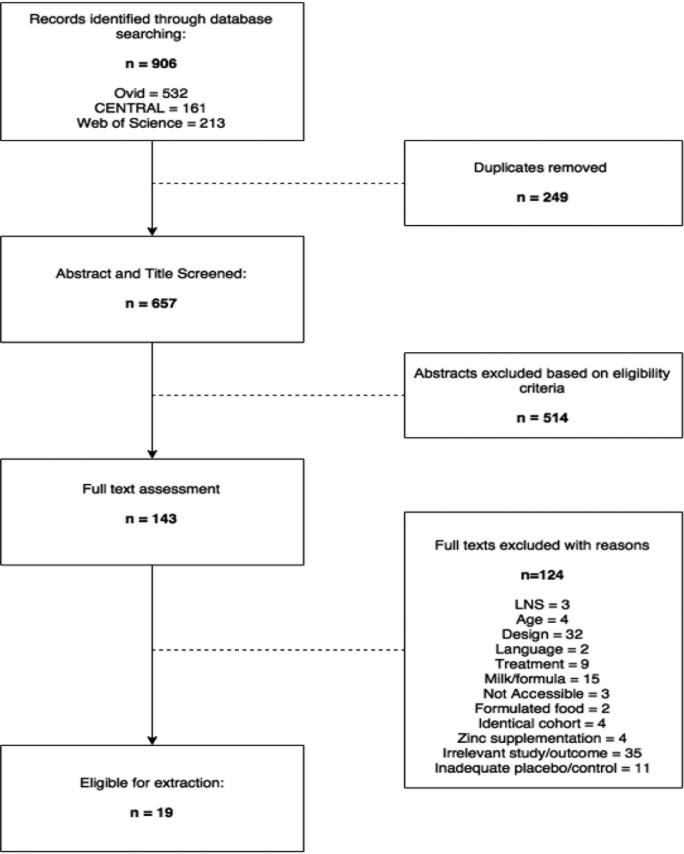
Study selection flow diagram. LNS, lipid-based nutrient supplement.